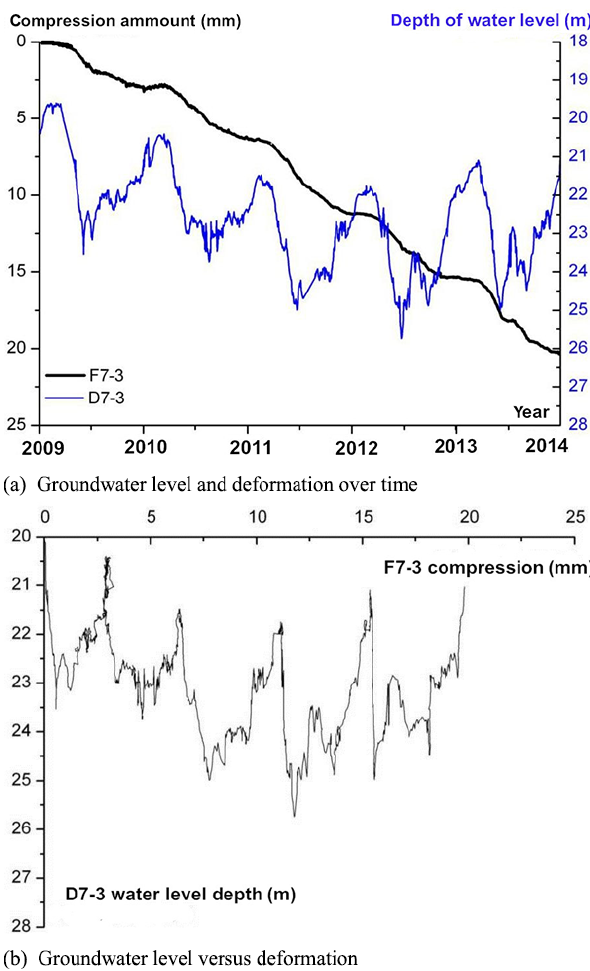
Figure 10. Deformation behaviour of the deep soil mass in relation to its corresponding groundwater level at layered mark